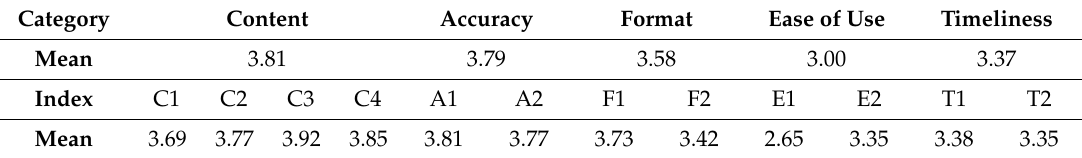
Table 12. Results of the end-user computing satisfaction (EUCS)